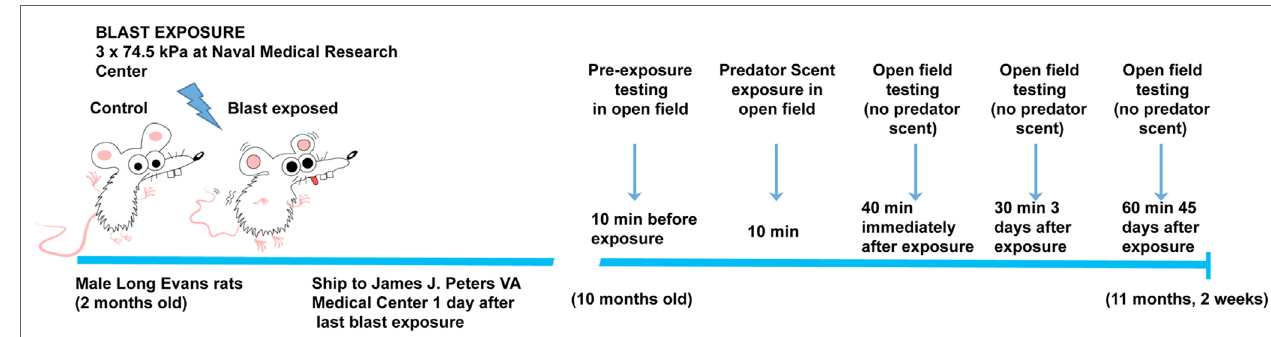
FigUre 1 | Time line of blast injury, predator scent exposure, and open field-testing . Blast exposure occurred at the Naval Medical Research Center when animals were 2 months of age. Animals were shipped to the James J. Peters VA Medical Center the day following the last blast exposure. Predator scent exposure occurred 8 months later when rats were 10 months old. Prior to predator scent exposure, subjects were placed in an open field chamber for 10 min, and activity was recorded. Rats were then transferred to an open field chamber containing cage bedding that had been soaked in cat urine. Activity was recorded during the 10 min of exposure. Rats were then transferred to a clean open field cage (no predator scent present), and activity was recorded for an additional 40 min. At 3 days postexposure, open field activity was recorded for 30 min (no predator scent present), and at 45 days postexposure, it was recorded for 60 min (no predator